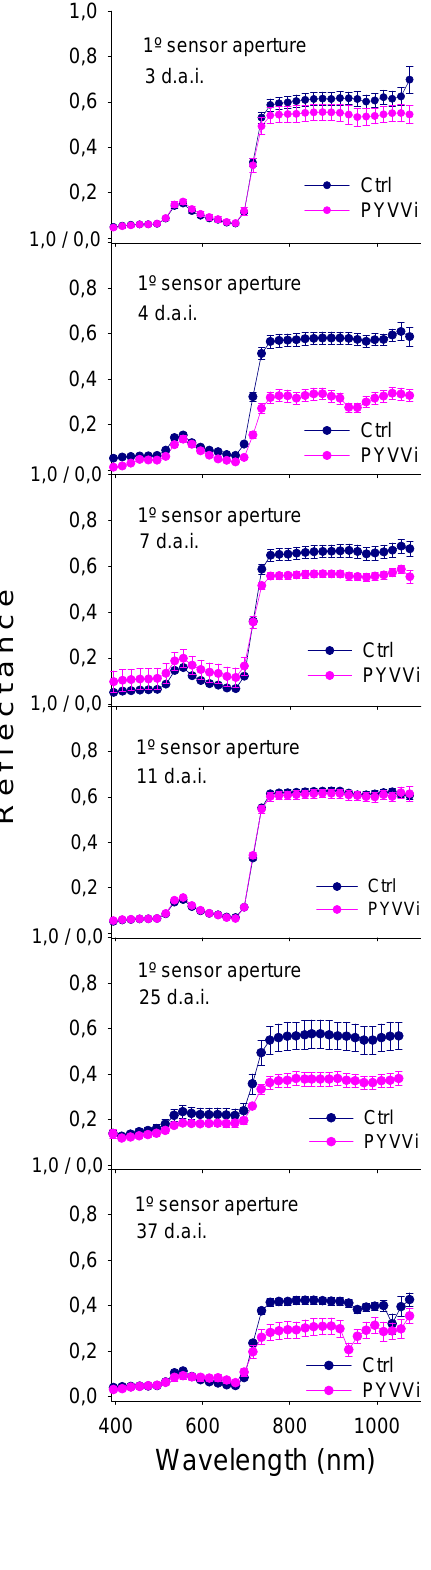
Figure 4. Passive reflectance of plants of both the first ( left ) and second experiments ( right ). Notice that the observable differences in the raw reflectance spectra registered by a sensor aperture of 25° ( left ) do not allow a clear treatments discrimination. In contrast, the spectra obtained by a sensor aperture of 1° ( right ) shows more clearly the differences in the spectra, at earlier